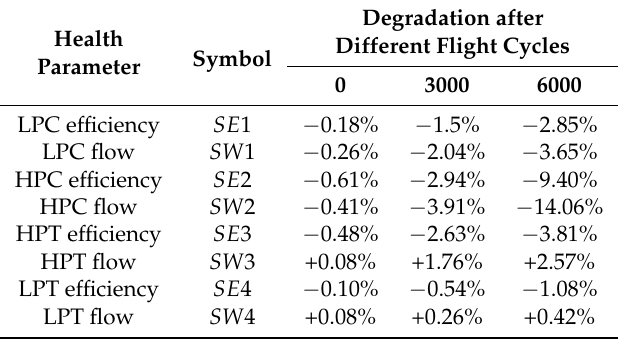
Table 5. Degradation of gas-path components after different flight cycles.